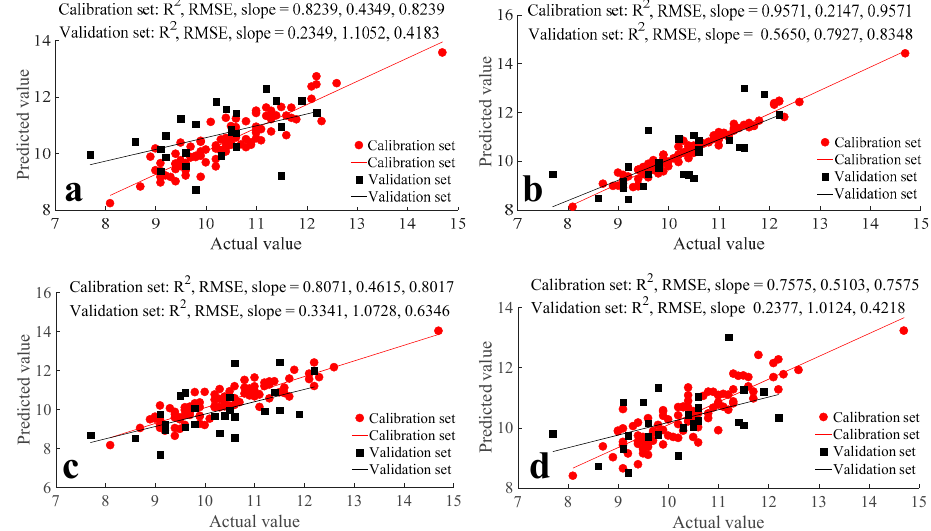
Figure 2. Partial least squares regression (PLSR) detection results of total soluble solid content (TSS) based on full spectral data of ( a ) stem position; ( b ) calyx position; ( c ) equator position; ( d ) position between equator and stem. RMSE: root mean squared error.